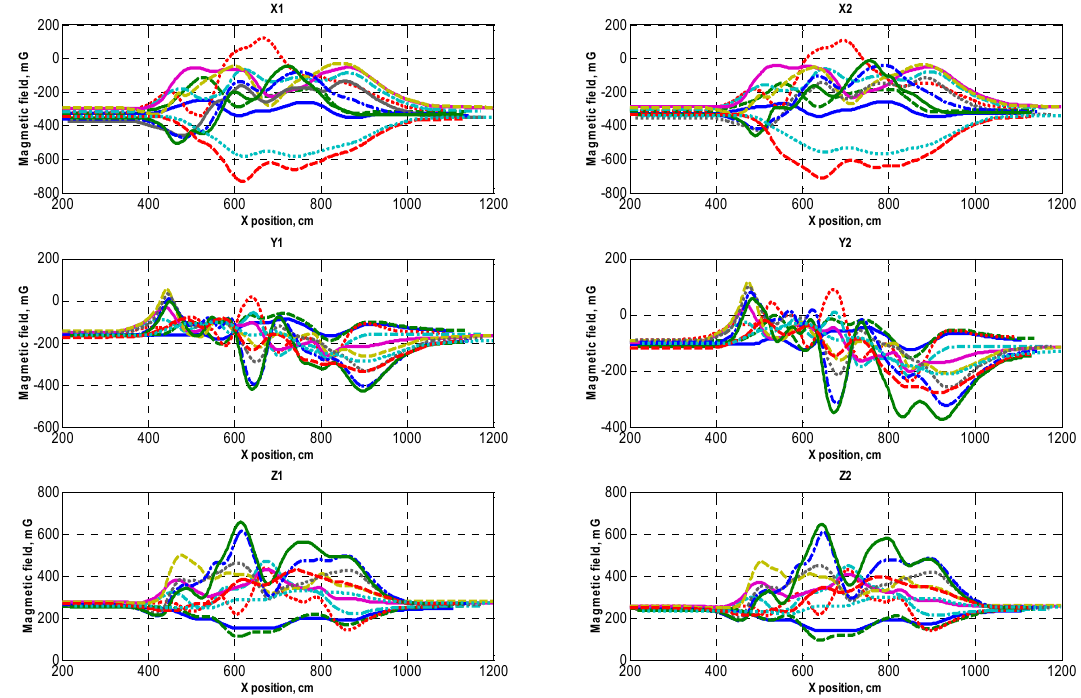
Figure 3. The distribution of the magnetic field measured by two distinct sensors (plots of magnetic field components X1, Y1, Z1 and X2, Y2, Z2 of sensors 1 and 2 respectively). Plot curves are color coded by sensor position along latitudinal vehicle line.